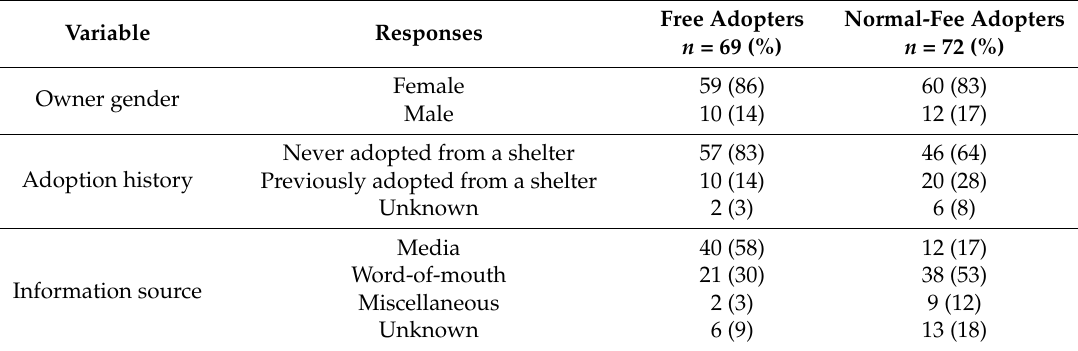
Table 3. Survey responses of free and normal-fee cat adopters including gender, previous adoption history with cat shelters, and how adopters originally learned about the Cat Haven shelter, WA. Over the free adoption-drive weekend, four survey respondents adopted a pair of cats; and six pairs of normal-fee cats were adopted during the normal non-promotional